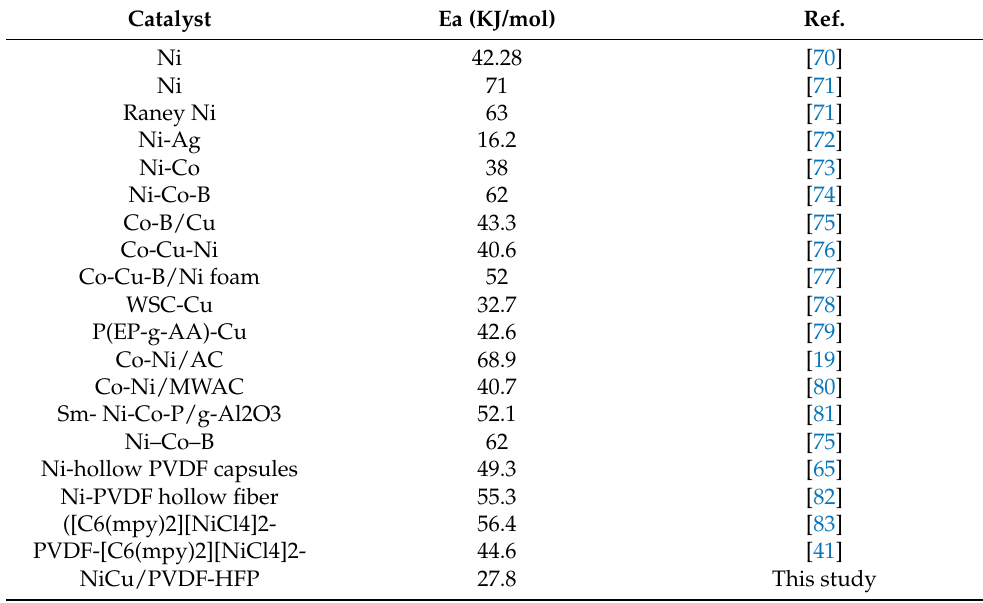
Table 1. Activation energies of Ni- and Cu-based catalysts for H 2 generation from